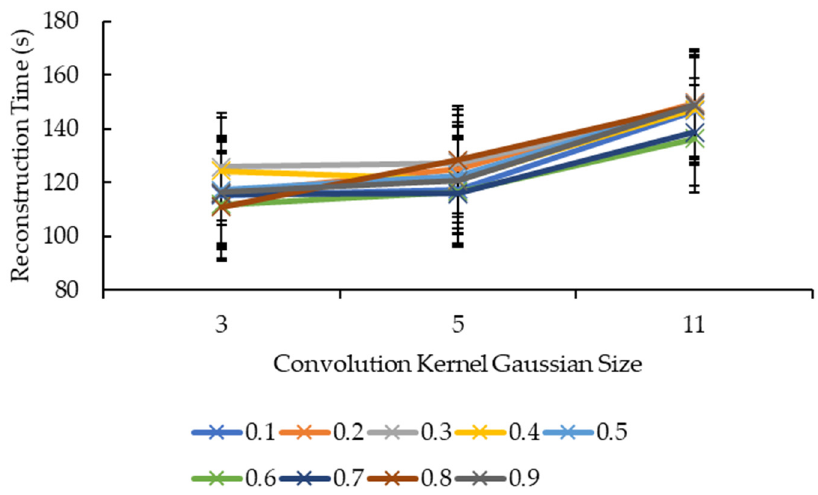
Figure 9. Graph of reconstruction time against convolution kernel size for convolution kernel Gaussian.